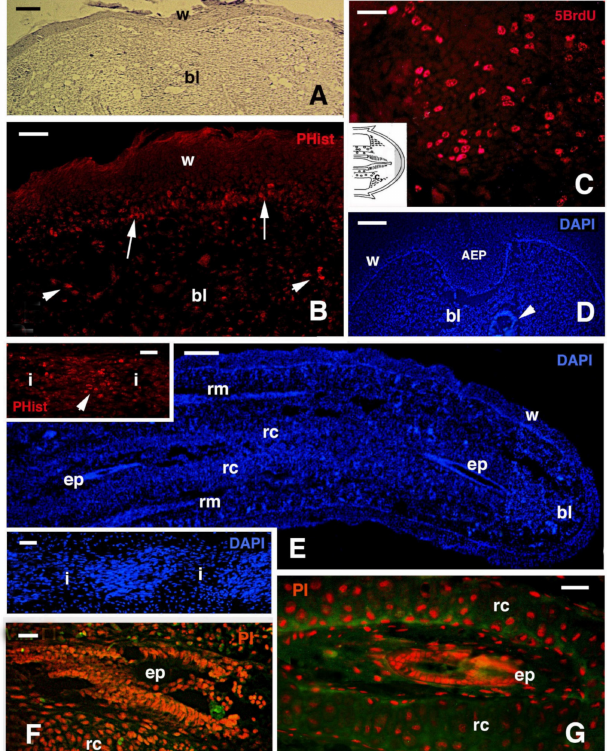
Figure 3. Histology ( A ) and fluorescence ( B – G ) of regenerating tails in Podarcis muralis . ( A ) Early blastema with covering wound epidermis at about 10 days post-amputation. Hemallume staining. Bar, 50 µ m. ( B ) Area of the blastema showing distribution in the wound epidermis (arrows) and the mesenchyme (arrowheads) of labeled cells for the proliferative marker Phospho-histone (PHhis). Bar, 20 µ m. ( C ) Detail on the numerous labeled nuclei for 5BrdU that are localized at the base of the blastema, near stump muscles (see ( C ) in the inset drawing). Bar, 10 µ m. ( D ) Close-up of the tip of a regenerating cone with the apical epidermal peg stained with the fluorescent DAPI dye for nuclei. Bar, 50 µ m. ( E ) Elongating tail showing the main tissues. Bar, 100 µ m. The upper inset (Bar, 10 µ m) shows labeled nuclei (arrowhead) for PHhistone-marker in proliferating cells (myoblasts). The lower inset (Bar, 10 µ m), stained with DAPI, shows the formation of segmental myotomes. ( F ) Apical ependymal canal surrounded by early differentiating cartilaginous cells and stained with propidium iodide (nuclei). Bar, 10 µ m. ( G ) Detail of the more proximal ependymal canal surrounded by differentiated chondrocytes forming a cartilaginous tube. Bar, 20 µ m. Legends: AEP, apical epidermal cap; bl, blastema; ep, ependyma; i, forming inter-muscle connective tissue; rc, regenerating/-ed cartilage; rm, regenerating muscles; w, wound